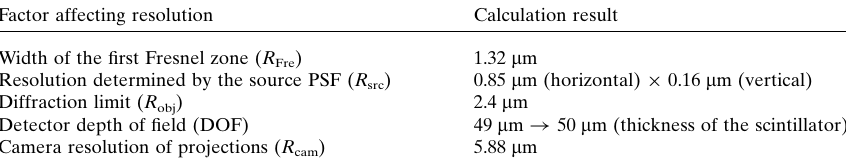
Table 3 Calculation results of the factors affecting the resolution in SRX imaging experiments at the BSRF 3W1 beamline. Factor affecting resolution Calculation result